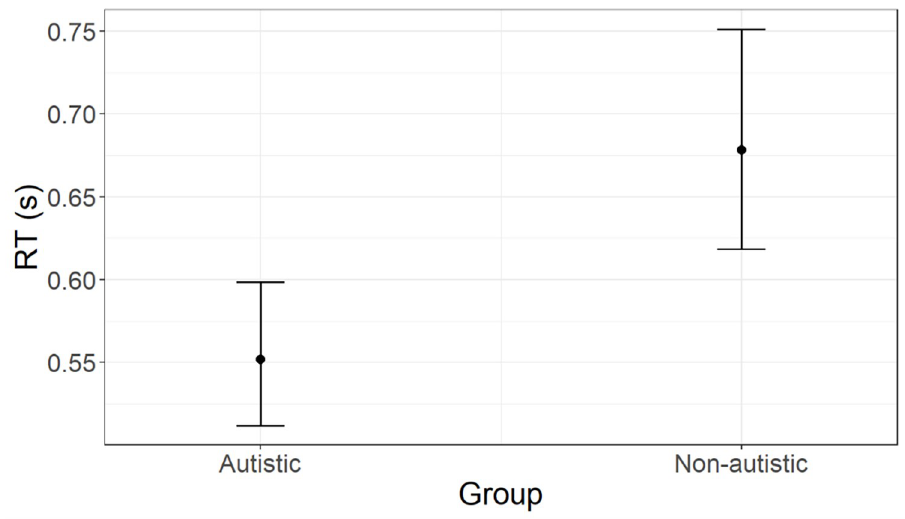
Fig 5. Group difference in RT (reward task), as predicted by model m2. Estimated marginal means with whiskers representing 95% confidence